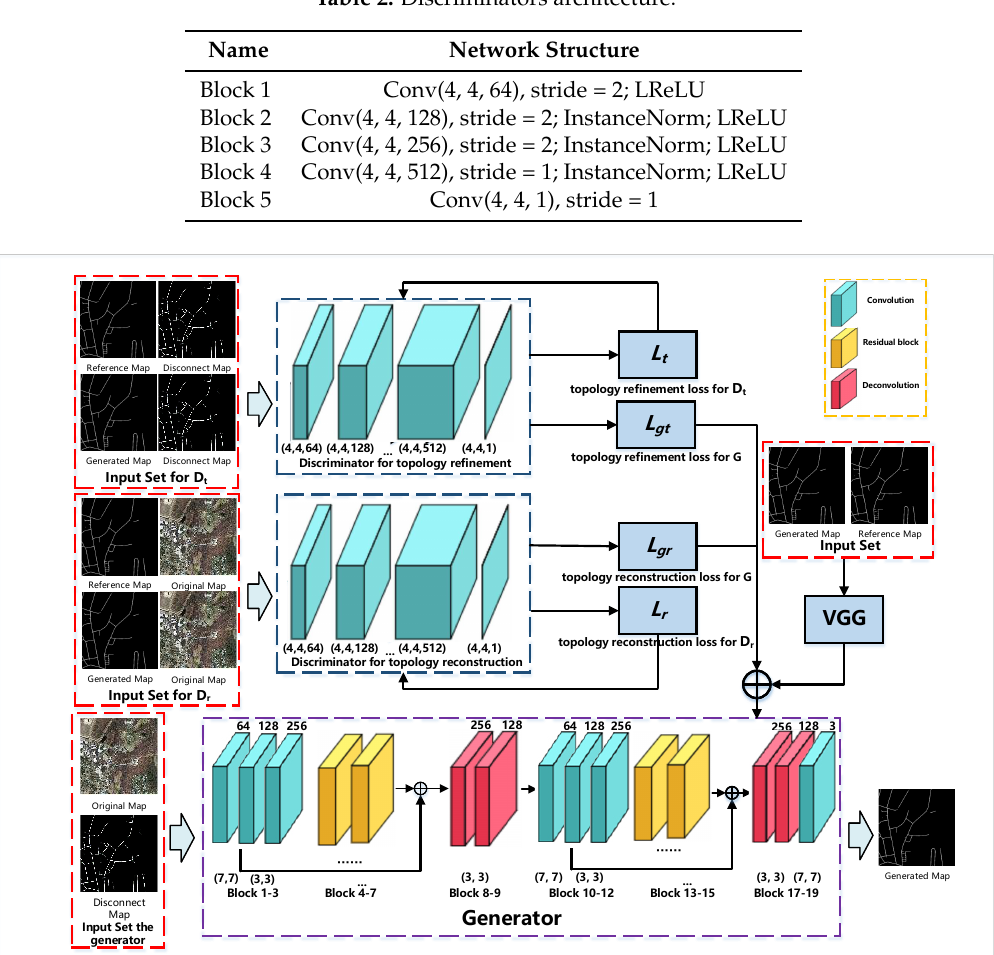
Figure 2. Network